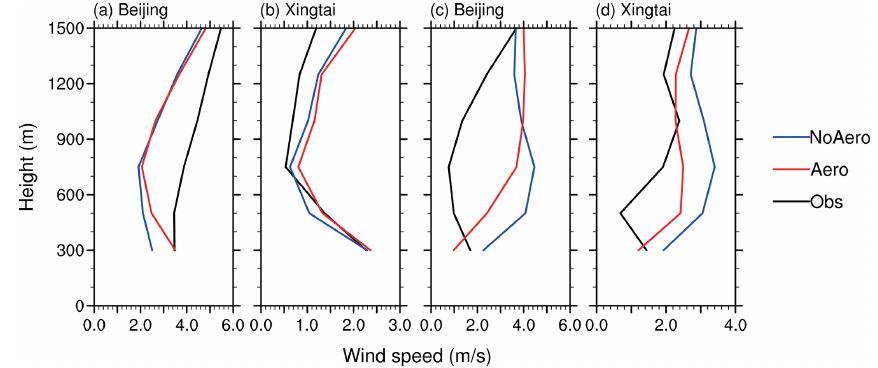
Figure 18. (a, b) Observed (black) and simulated (NoAero: blue, Aero: red) vertical profiles of atmospheric wind speed (ms − 1 ) at (a) Beijing and (b) Xingtai at 08:00LT averaged from 6 to 10 December. Panels (c, d) are the same as (a, b) , but at 20:00LT.